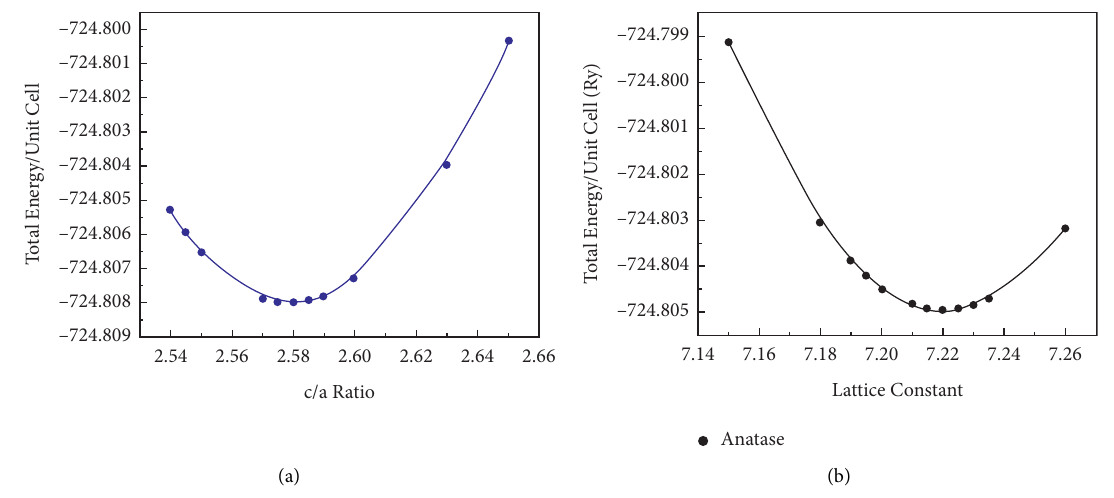
Figure 2: (a) c / a ratio optimization and (b) lattice parameter a optimization at c / a � 2.58 of anatase unit